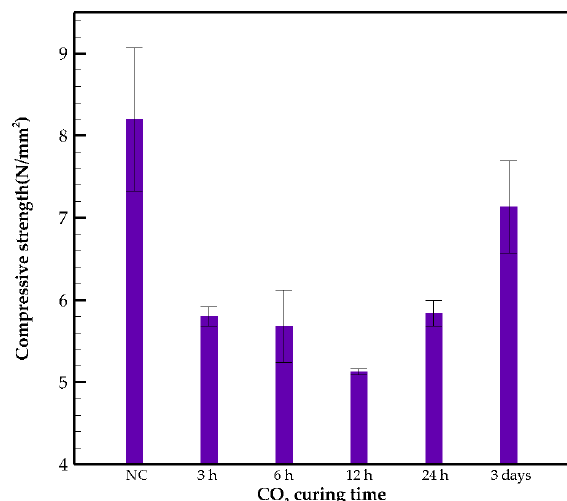
Figure 7. 28 days’ compressive strength.